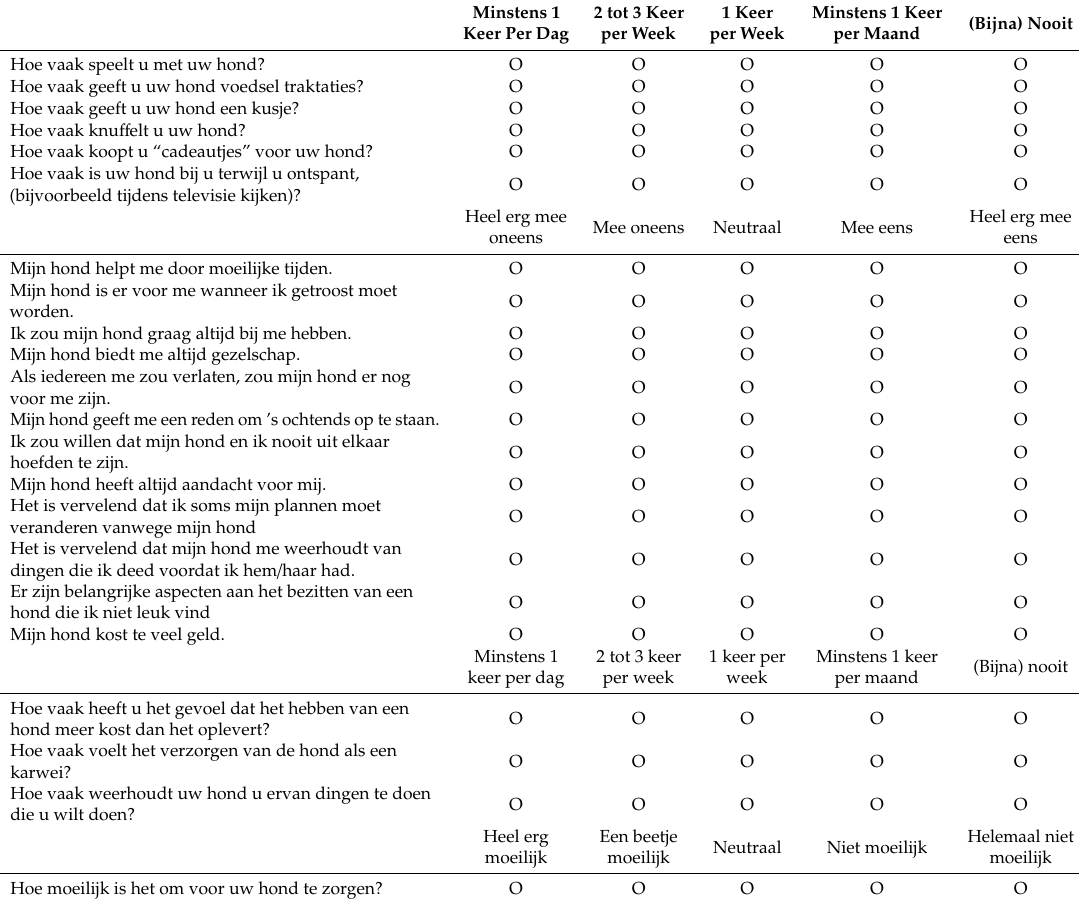
Table A1. The questions that were retained in the Dutch